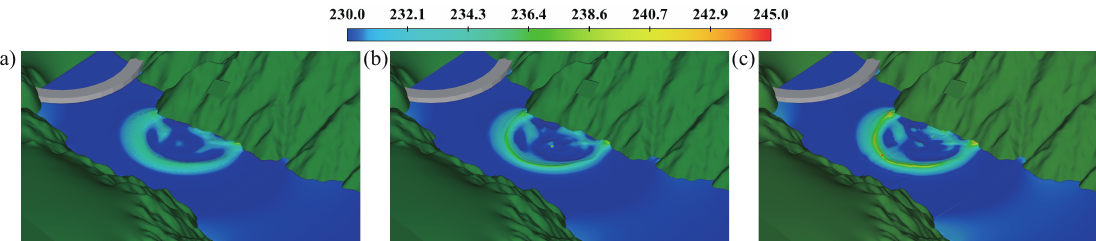
Figure 12. Wave height in the propagation field at t = 30 s: ( a ) 6-m global uniform mesh; ( b ) 3-m global uniform mesh; and ( c ) mesh scheme solution.